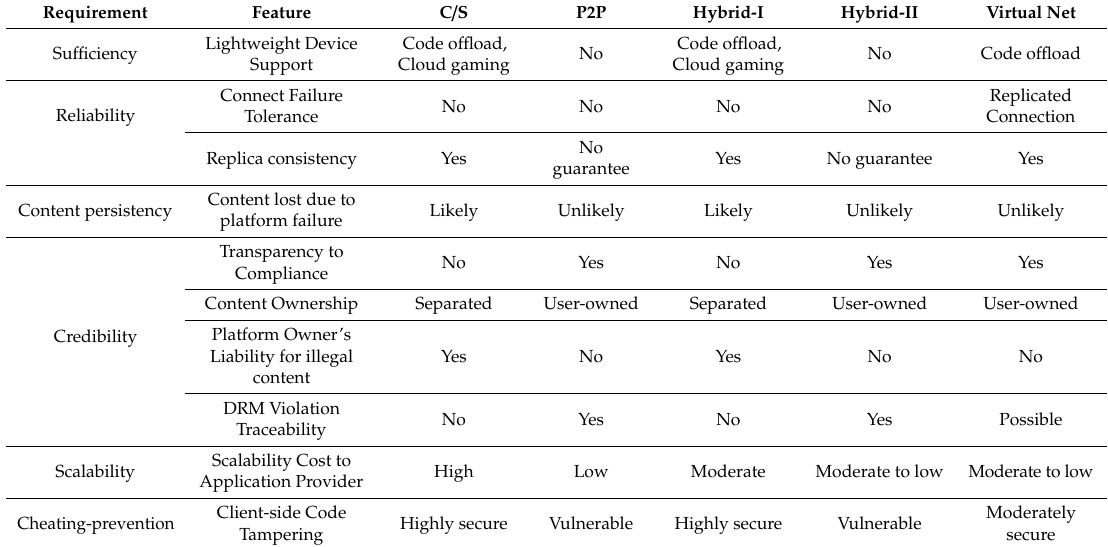
Table 2. Features comparison of virtual world